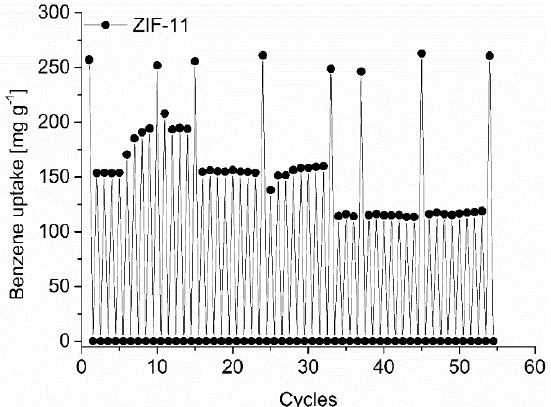
Figure 8. Benzene cycling test of ZIF-11 with 55 ad/desorption cycles up to a relative pressure of p p 0 − 1 = 0.3 and a full adsorption measured every few cycles and at the end of the 55 cycles.